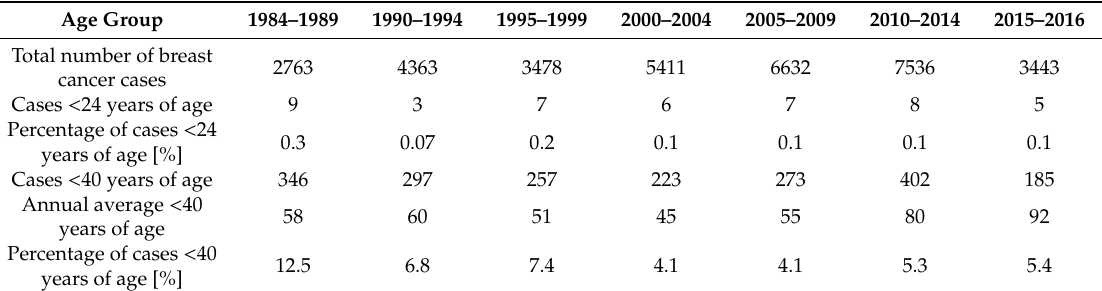
Table 2. Numbers of malignant neoplasm of breast cases in women under the age of